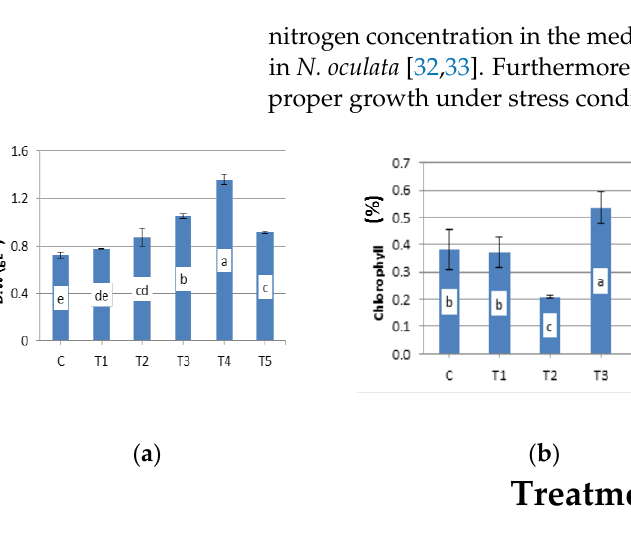
Figure 3. ( a ) Dry weight (g.L −1 ), ( b ) total chlorophyll (%), and ( c ) total carotenes (%) of N. oculata grown under stress of 2.0% salinity, nitrogen deficiency, 25% F2 medium, and 10% bagasse extract.